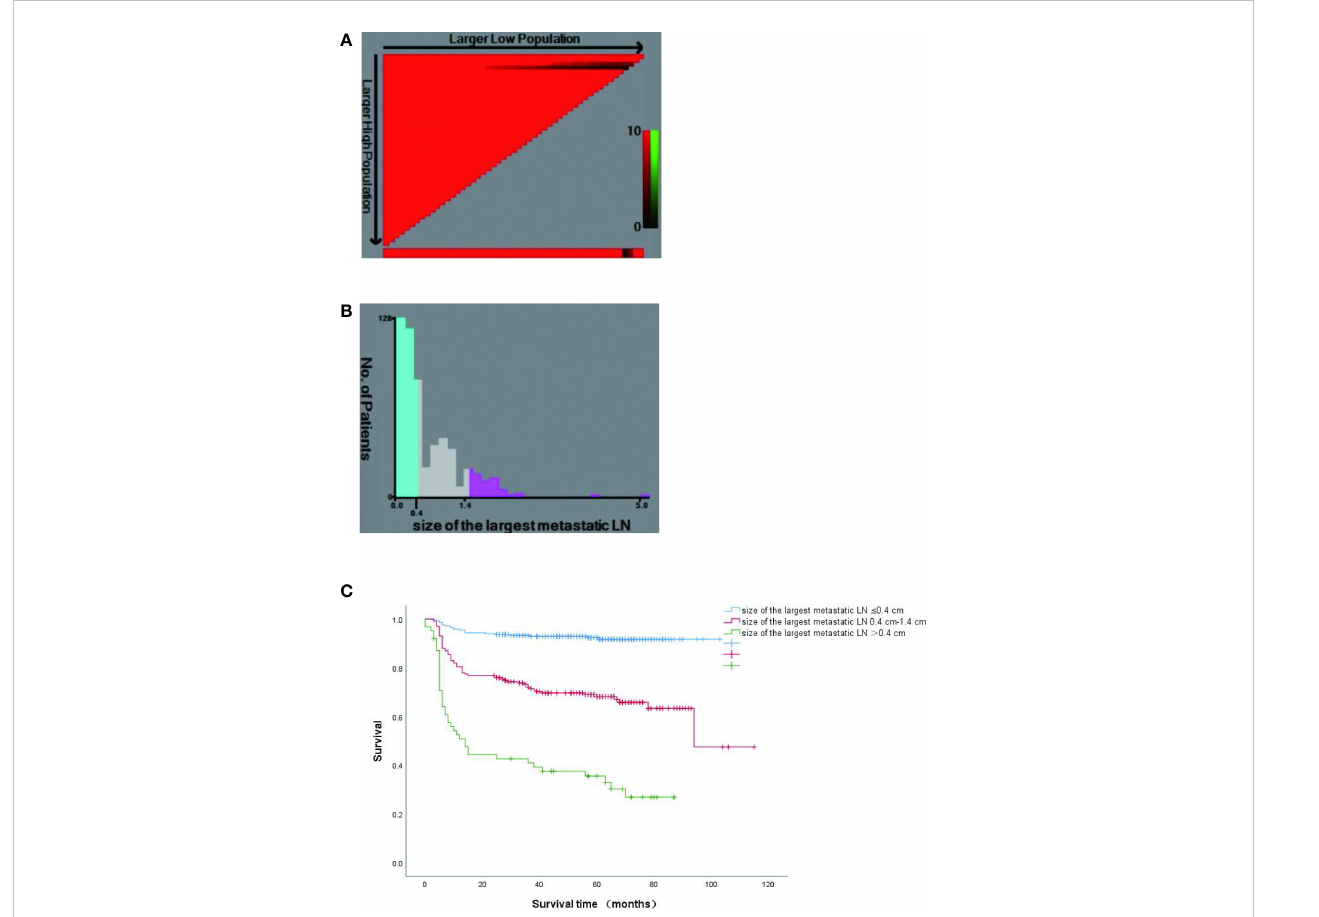
FIGURE 3 (A) The X-tile software of size of the largest metastatic LN for the prediction of persistent/recurrent disease vs long-term remission. (B) Patient frequency according to the size of the largest metastatic LN (the optimal cutoffs were 0.4cm and 1.4cm); (C) Kaplan Meier survival curves for different risk groups (P < 0.001).